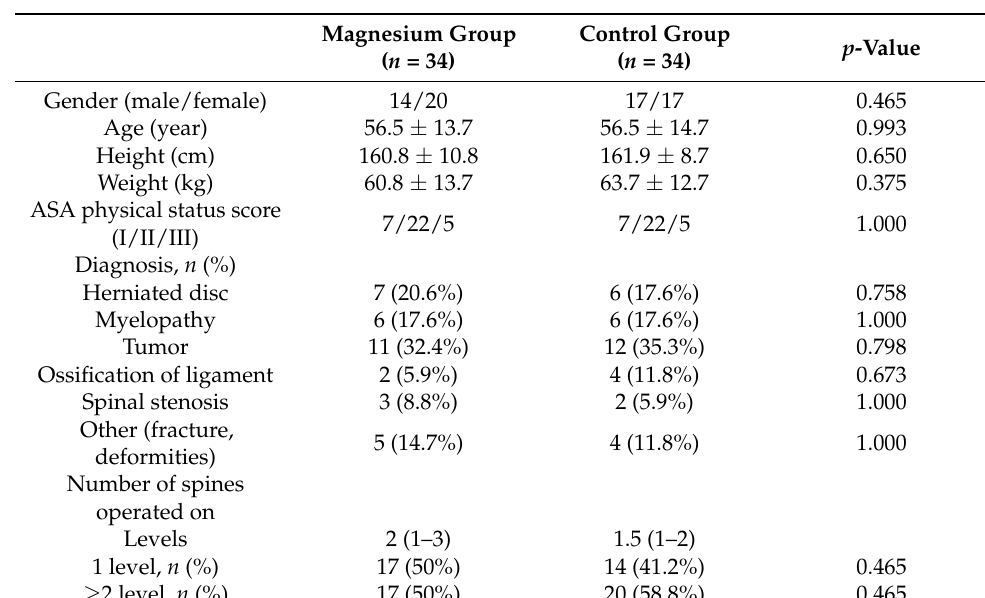
Figure 1. CONSORT diagram. BIS, bispectral index; TIVA, total intravenous anesthesia. Table 1. Baseline characteristics of patients and perioperative data assigned to magnesium or the control